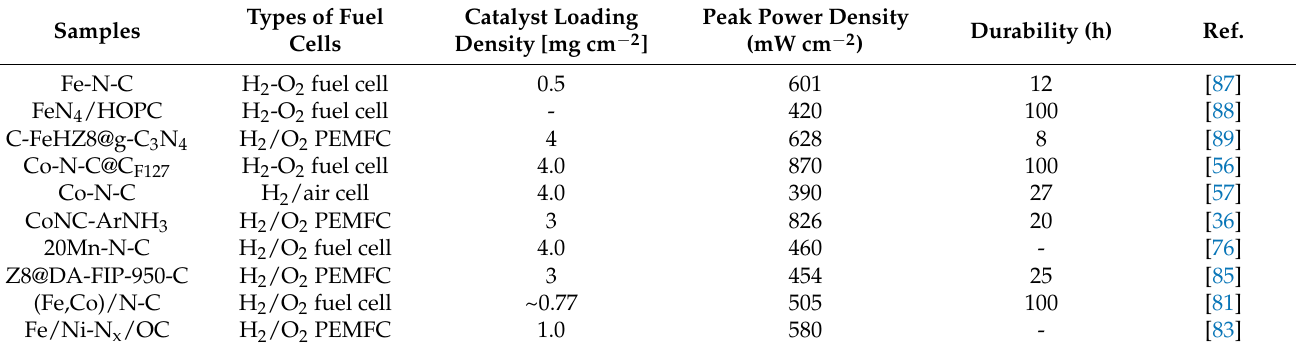
Table 1. The performance of fuel cells with recently reported M SAC -N-C catalysts derived from